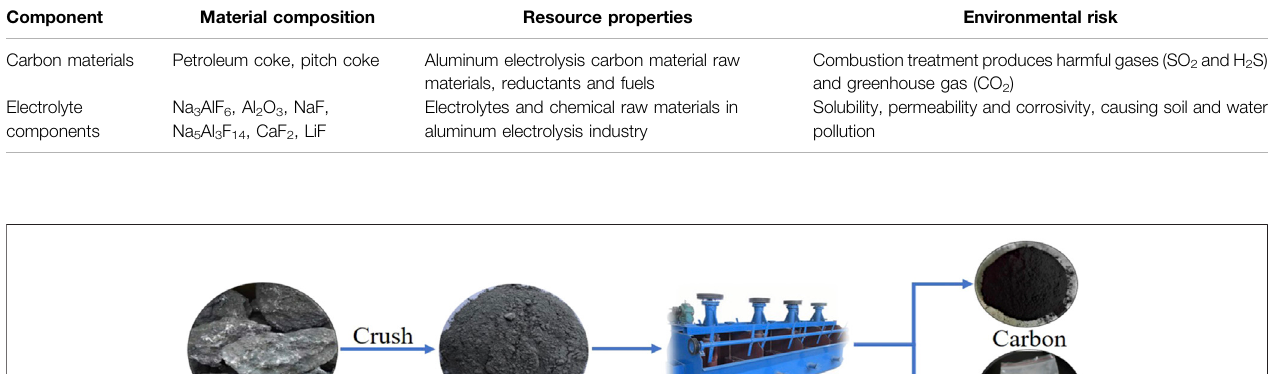
TABLE 1 | Material composition, resource attributes, and environmental risk of SCA. Component